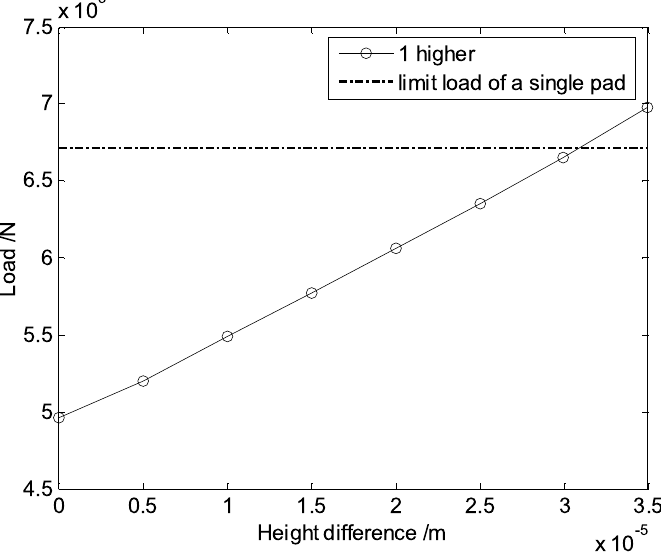
Fig. 11. Maximum load of all pads when one pad has larger height.